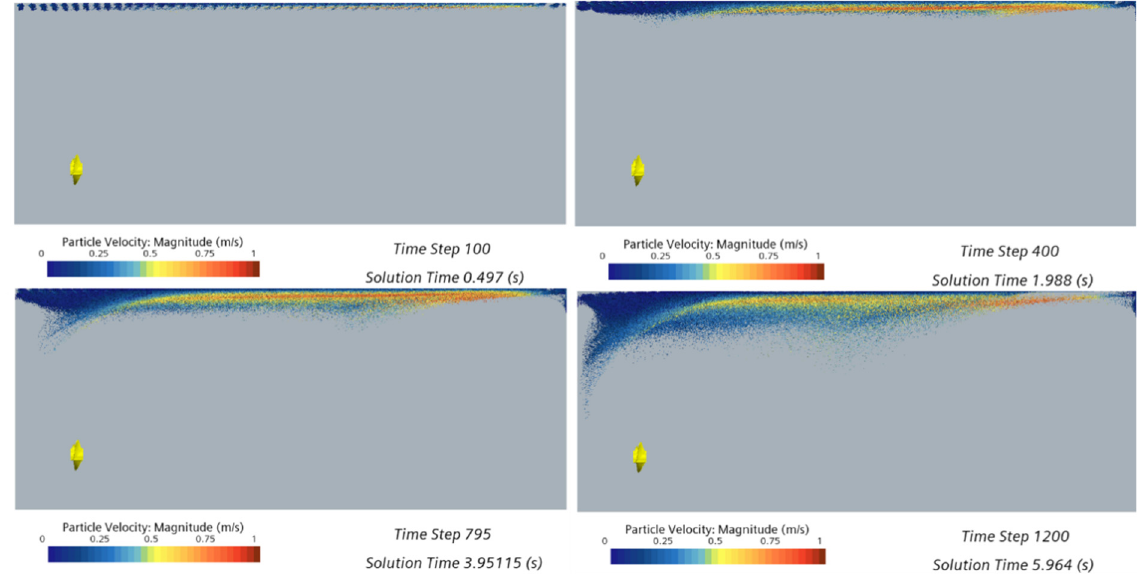
Figure 9. Horizontal development stage.